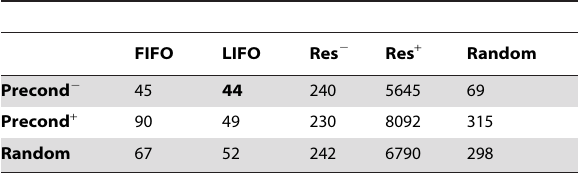
Table 1. Comparison of heuristics in Graphplan backward search